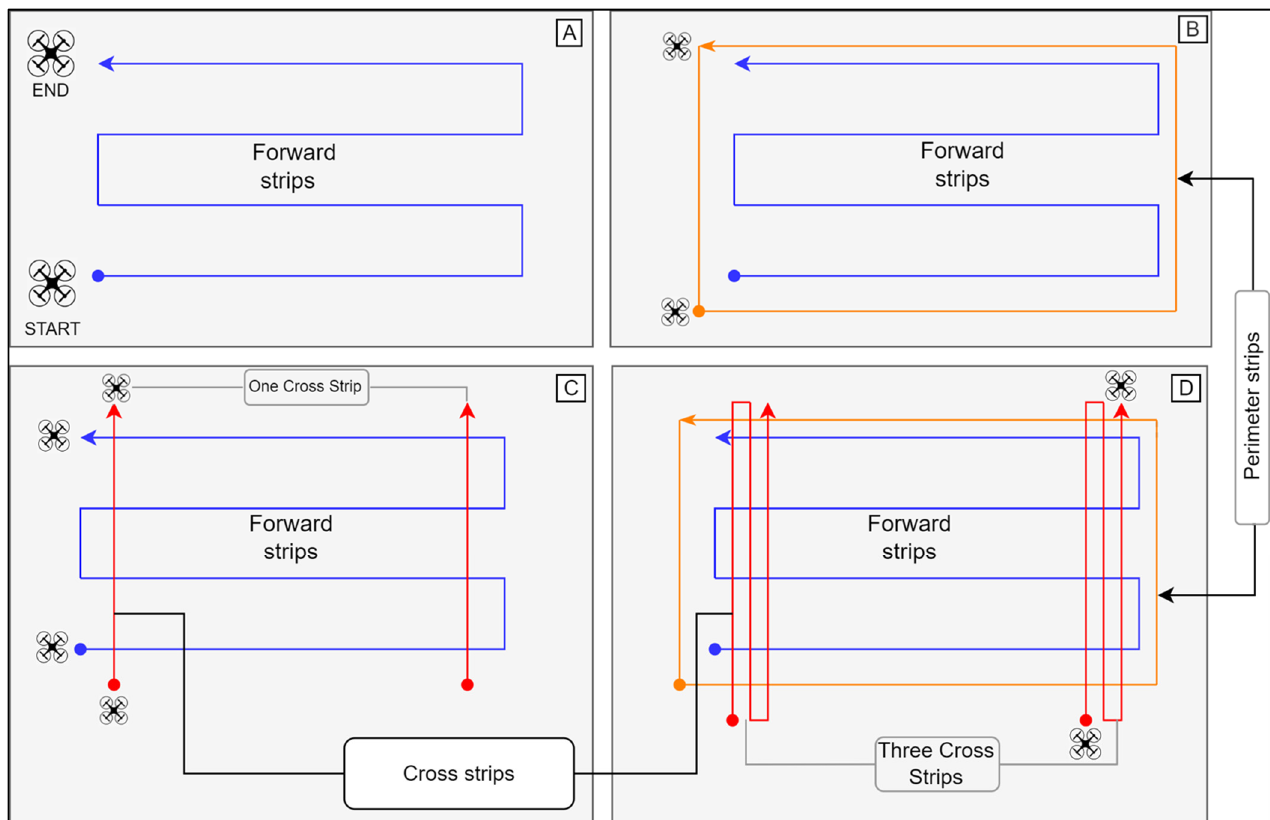
Figure 7. Processing of each scenario: ( A ) Scenario A, processing of photographs with conventional flight planning; ( B ) Scenario B, Scenario A plus the block perimeter; ( C ) Scenario C, Scenario A plus one cross strip at each edge; ( D ) Scenario D, Scenario B plus three cross strips at each edge. Scenarios A, B, and C are image subsets of Scenario